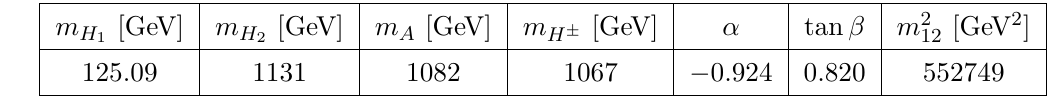
Table 21 . SMEFTBP1 : R2HDM-II input parameters.